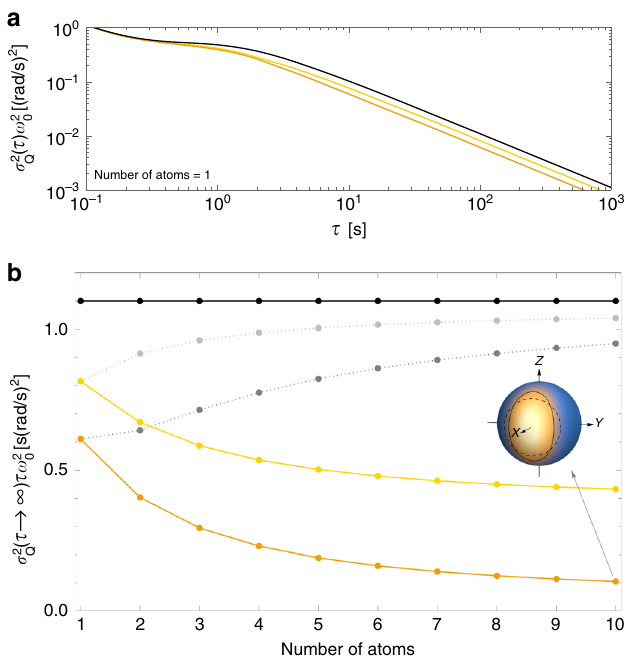
Fig. 3 Quantum Allan Variance in the atomic clock stabilization model. ) as a function of the averaging time τ for the atomic clock a QAVAR (times ω 2 0 (based on one atom) with the local oscillator (LO) noise, which is strictly local (yellow line) or also includes the nearest neighbors correlations (orange line), plotted against the AVAR of uncorrected LO (black line). b QAVAR asymptotic coef fi cient as a function of the number of atoms in the atomic clock with LO noise, which is strictly local (yellow dots connected by solid line/light gray dots connected by dotted line) or also includes the nearest neighbors correlations (orange dots connected by solid line/gray dots connected by dotted line) for the optimal/NOON state, plotted against the AVAR asymptotic coef fi cient of uncorrected LO (black dots connected by solid line). The sphere depicts Husimi Q distribution on the Bloch sphere for the optimal state of ten atoms with marked equipotential lines where quasiprobability is equal to 0.1 for coherent spin state (black dashed line) and for this optimal state (black solid line), which shows that the state is squeezed.